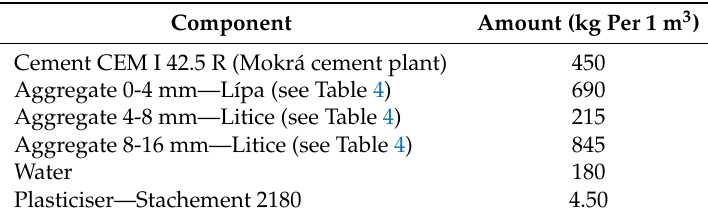
Table 6. Composition of concrete C